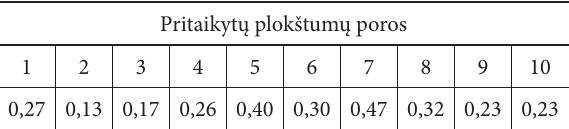
Table 1. Differences between revised and real break line of sur- face, m Pritaikytų plokštumų poros